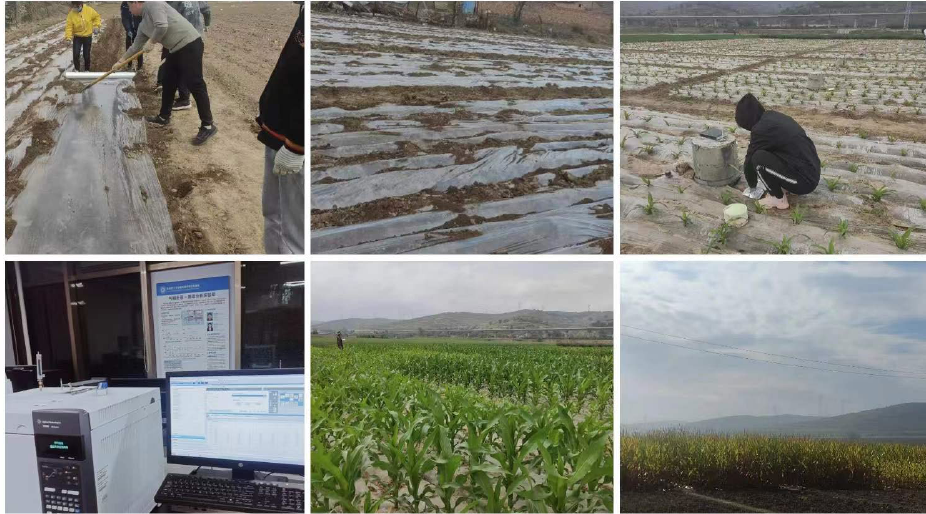
Figure 2. Photos of the experiment.